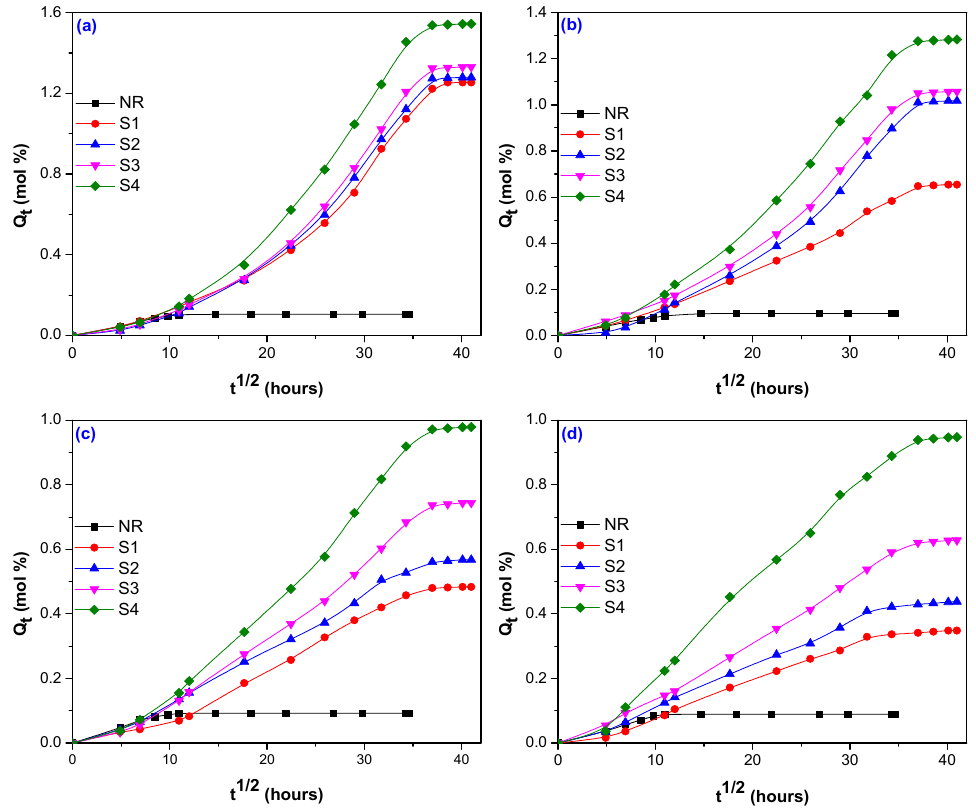
Figure 3. Q t variation versus immersion time for blends based on NR and sawdust, irradiated at 75 kGy ( a ); 150 kGy ( b ) ; 300 kGy ( c ) ; and 600 kGy ( d ).